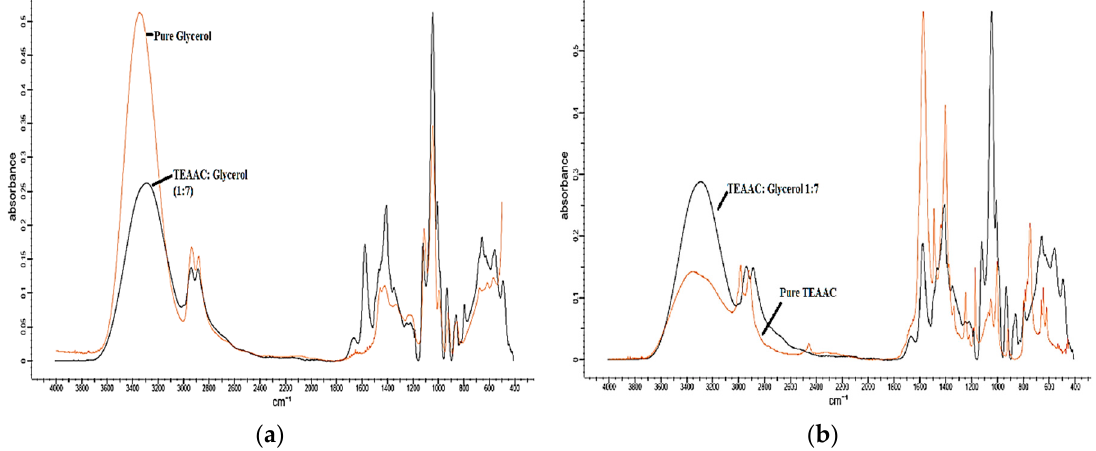
Figure 3. The FTIR comparison of TEAAC:Glycerol with ( a ) pure Glycerol and ( b ) pure TEAAC. TEAAC, Tetraethylammonium Acetate.